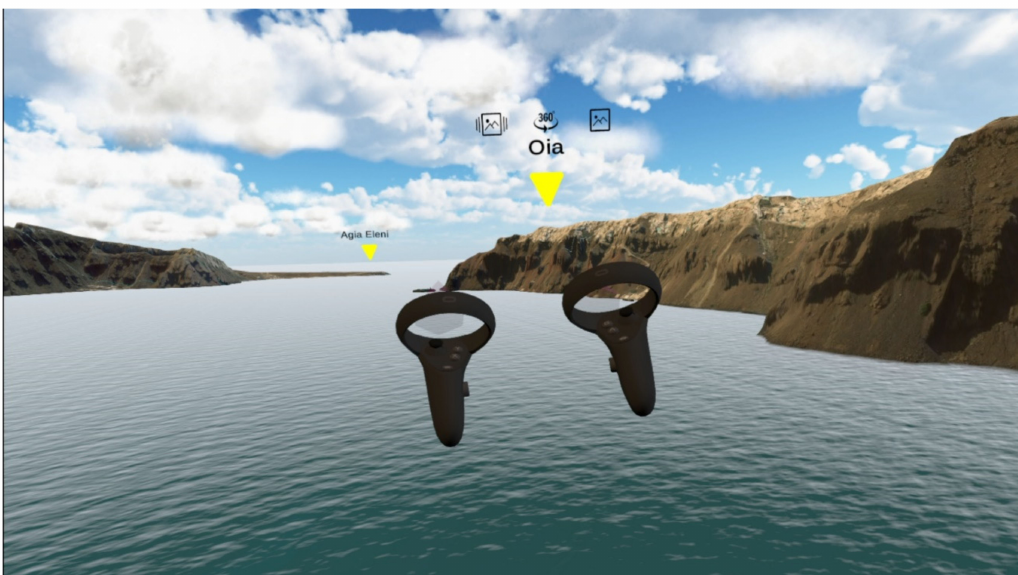
Figure 15. Fly Mode: User can navigate onto 3D terrain of Santorini, locate POIs and select them to enter Walk Mode. (3D Model has been produced by Up2metric VIRTUALDriver partners)